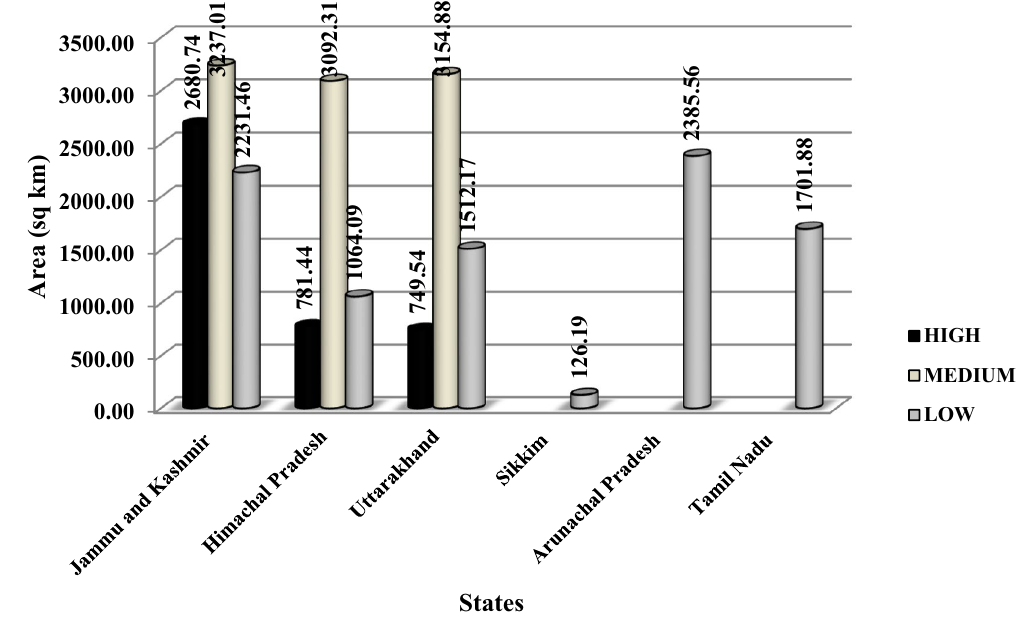
Figure 1. State-wise probable areas suitable for saffron cultivations in